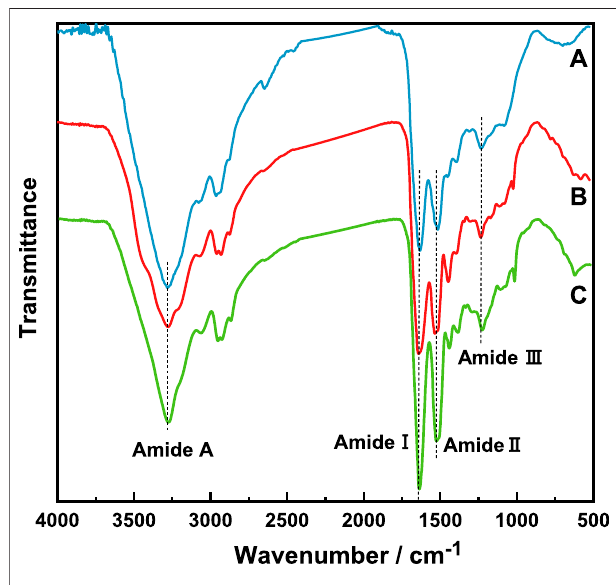
FIGURE 2 | IR spectra of natural wool and wool keratin samples. (A) Natural wool, (B) K-C, (C) K-M.